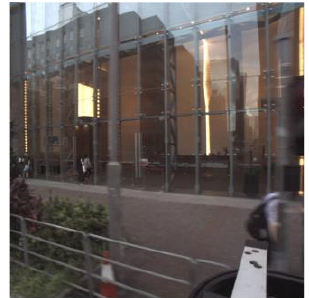
Figure 13. Comparison of the 3D models in another narrow alley where the MMS only obtained images at its two